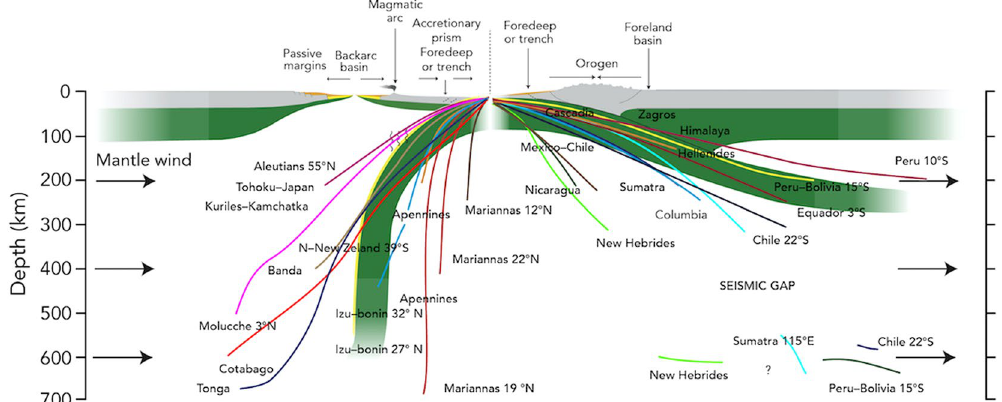
Figure 3. This picture shows our two models (in green), compared with a compilation of the slab dip measured along cross-sections perpendicular to the trench of most subduction zones. Each line represents the mean trace of the seismicity along every subduction. Some E- or NE-subduction zones present a deeper scattered cluster of hypocentres between 550–670 km. Dominant down-dip compression occurs in the W-directed intraslab seismicity, whereas down-dip extension prevails along the opposed E- or NE-directed slabs. The W-directed slabs are, on average, dipping 65.6°, whereas the average dip of the E- or NE-directed slabs, to the right, is 27.1° (modified) 11 . In our models the dip of the slab fits within this average by assuming intensity of the horizontal mantle flow of 3 cm yr − 1 . In this figure the differences in topography and state of stress between the upper plates of both models can be